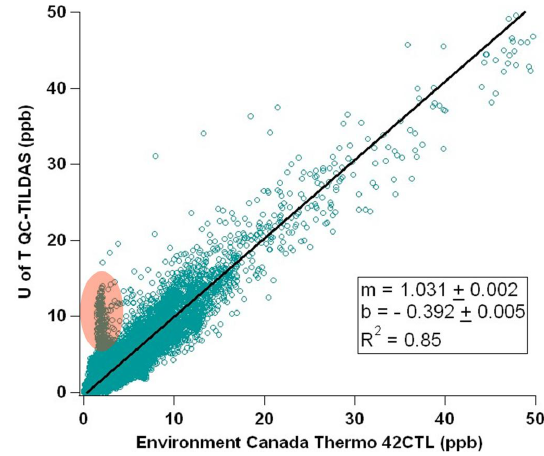
Fig. 6. Correlation plot of the QC-TILDAS and Thermo 42CTL. Most of the scatter can be explained by differences in inlet design and background subtraction methods. The time period outlined in red is shown in Fig.